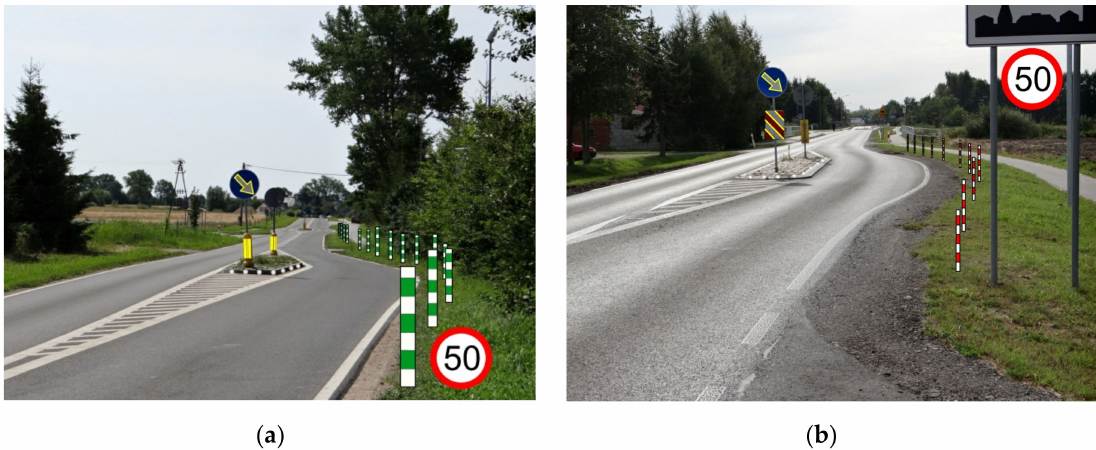
Figure 18. A visualisation of improved chicane surroundings due to the use of: the B-33 sign (50 km/h speed limit) placed close to the chicane, reflective road edge marker posts or chain fences, solar-powered vertical signs, additional kerb-mounted omnidirectional or LED SolarCAP type elements: ( a ) using the example of test section No. 7; ( b ) using the example of the test section No.